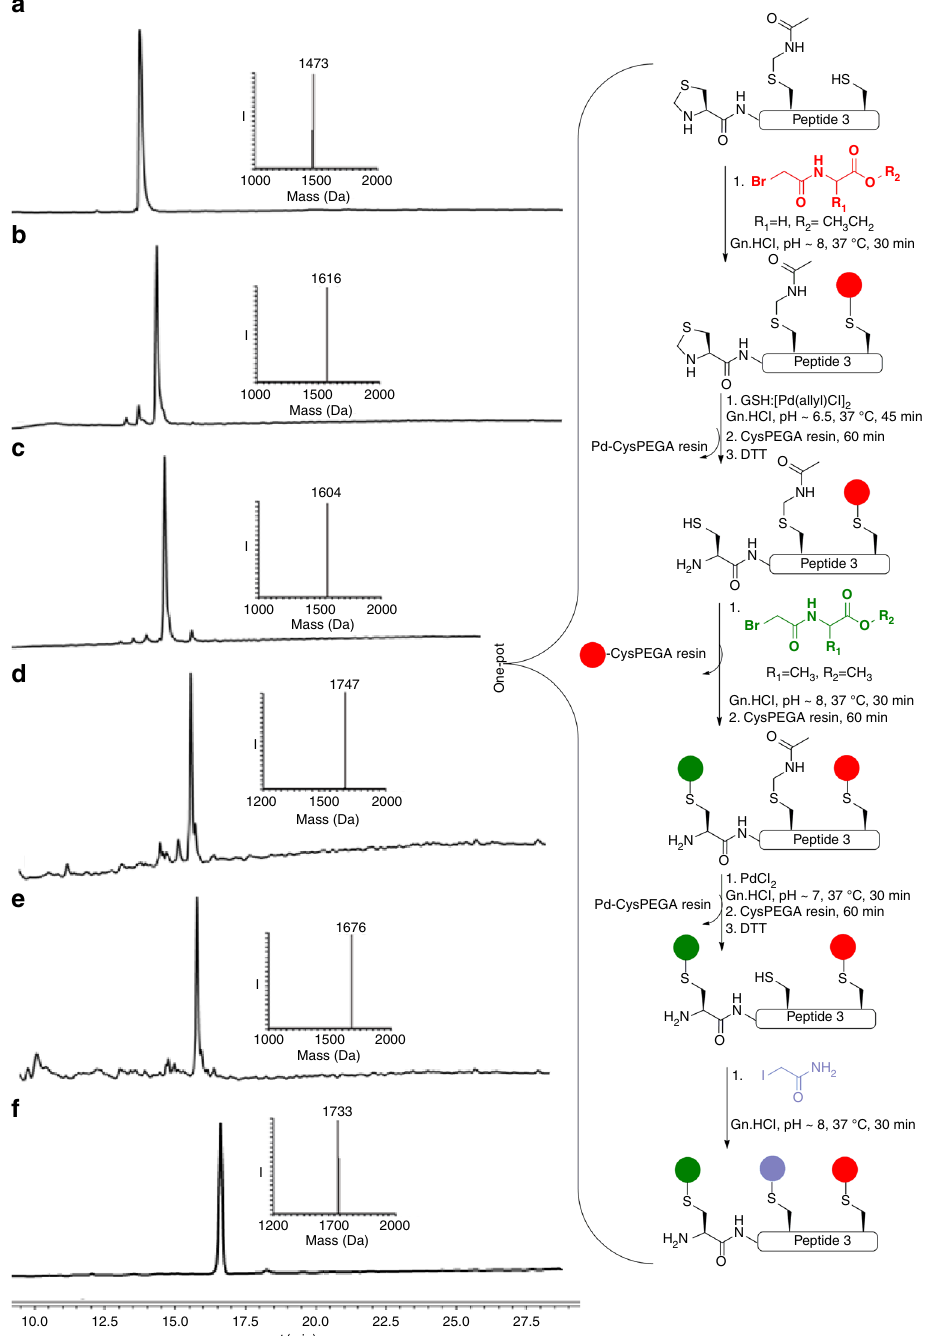
Fig. 3 Schematic representation of palladium-mediated modi fi cation of peptide 3 at selected Cys sites. a Reaction at time zero: main peak corresponds to peptide 3 with the observed mass 1473.0 Da ± 0.4 Da, calcd 1473.7 Da (average isotopes). b 1st alkylation reaction, main peak corresponds to mono- alkylated peptide 3 with the observed mass 1616.0 Da ± 0.5 Da, calcd 1616.7 Da (average isotopes). c Thz opening: main peak corresponds to Thz- deprotected peptide 3 with the observed mass 1604.0 Da ± 0.7 Da, calcd 1604.7 Da (average isotopes). d 2nd alkylation reaction: main peak corresponds to di-alkylated peptide 3 with the observed mass 1747.0Da ± 0.4 Da, calcd 1747.7 Da (average isotopes). e Acm deprotection: main peak corresponds to Acm-deprotected peptide 3 with the observed mass 1676.0 Da ± 0.4 Da, calcd 1676.7Da (average isotopes). f 3rd alkylation reaction: main peak corresponds to tri-alkylated peptide 3 with the observed mass 1733.0 Da ± 0.4 Da, calcd 1733.6 Da (average isotopes). Red sphere: acetylglycine-ethyl ester, green sphere: acetylalanine-methyl ester, purple sphere: